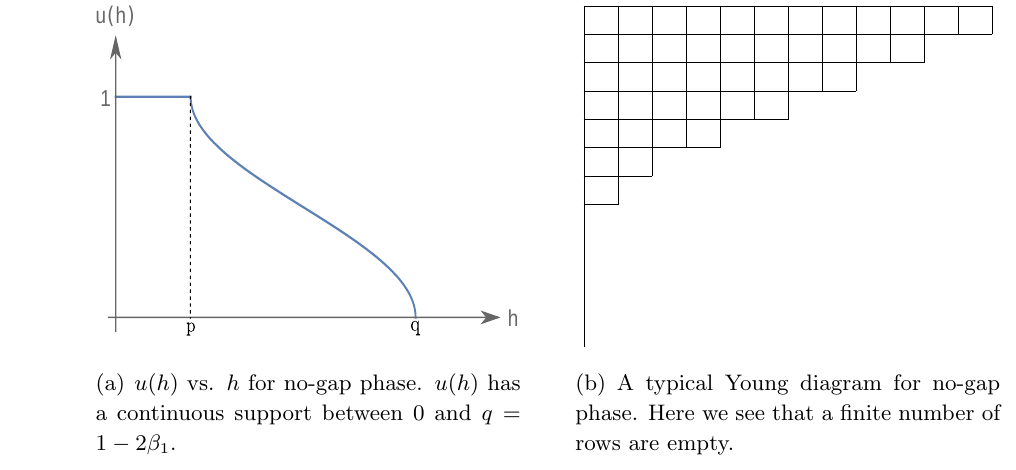
Figure 2 . Young distribution and Young diagram for no-gap